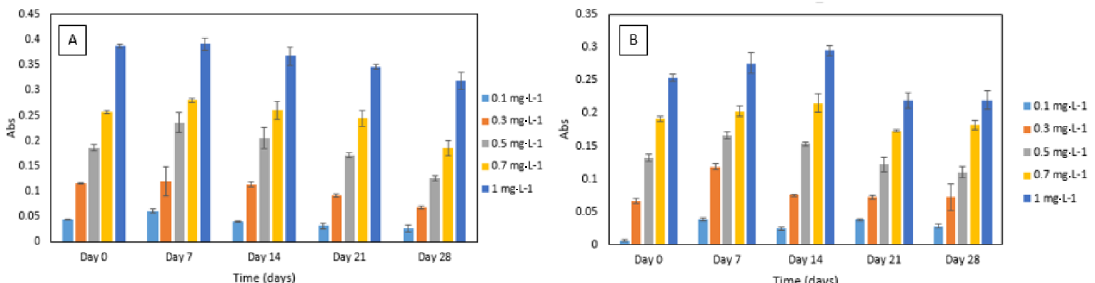
Figure 6. ( A ) Stability of 1,5-diphenylcarbazide (DPC) dye in Cr VI (0.1–1 mg · L − 1 ) analysed periodically over day 0, 7, 14, 21 and 28. All measurements were carried out in triplicate ( n = 3); ( B ) stability of sulphuric acid and DPC dye mixture in Cr VI (0.1–1 mg · L − 1 ) analysed periodically over day 1, 7, 14, 21 and 28. All measurements were carried out in triplicate ( n = 3).